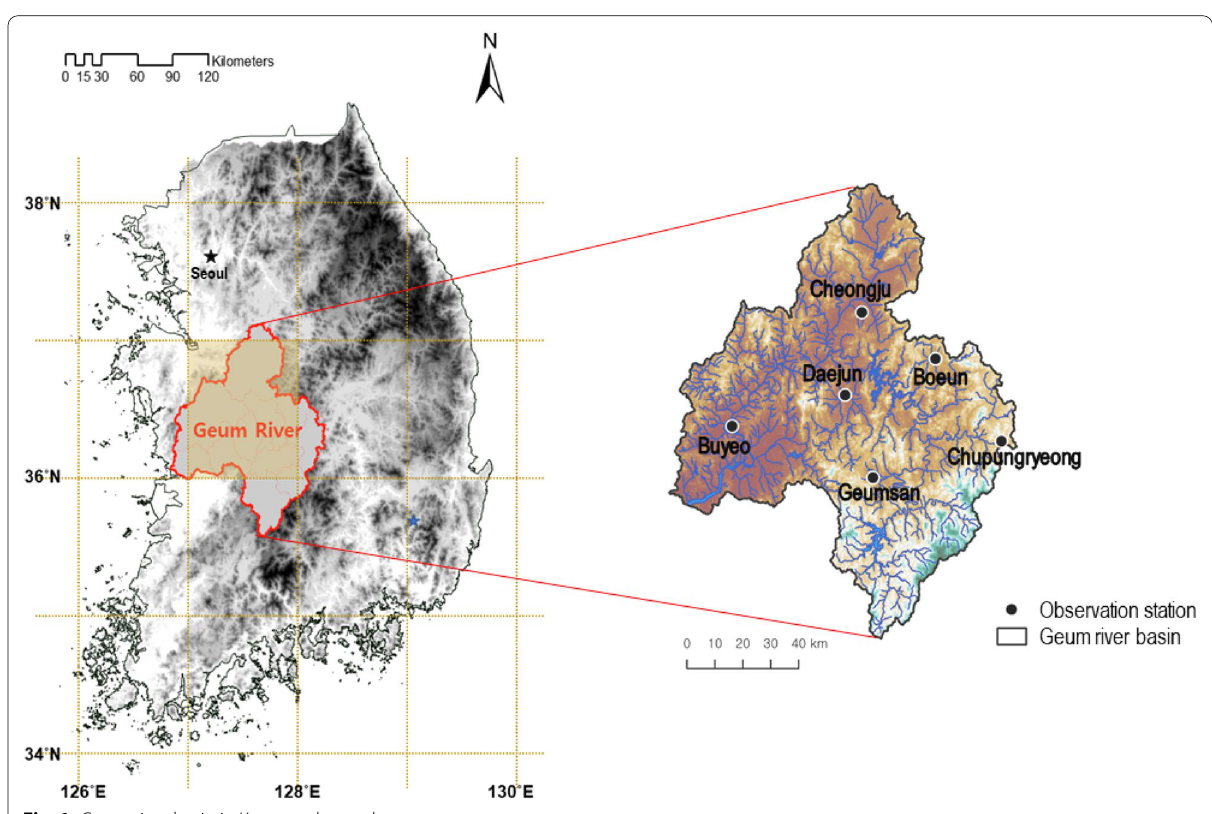
Fig. 1 Geum river basin in Korea as the study area